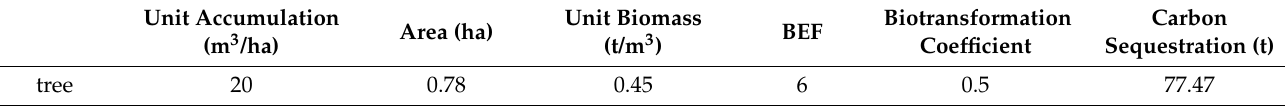
Table 5. Carbon sequestration calculation of tree.